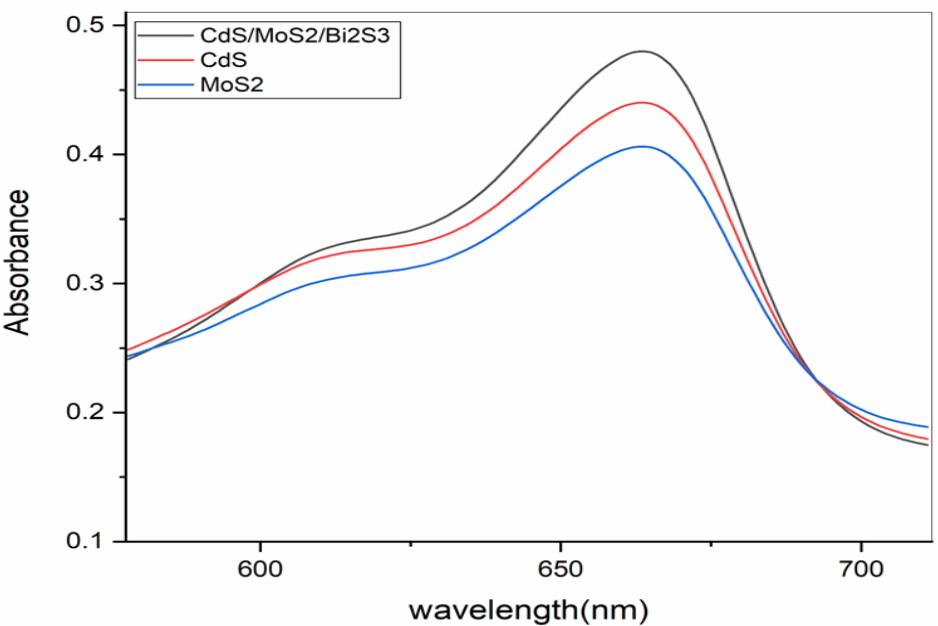
Figure 4. UV-Vis spectrum (CdS/MoS2/Bi 2 S 3 , CdS, and MoS 2 ) before degradation.